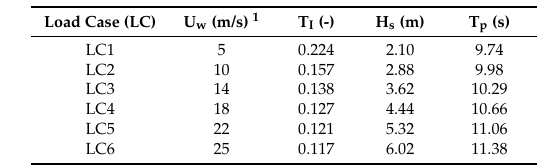
Table 4. Environmental loading for normal operating conditions